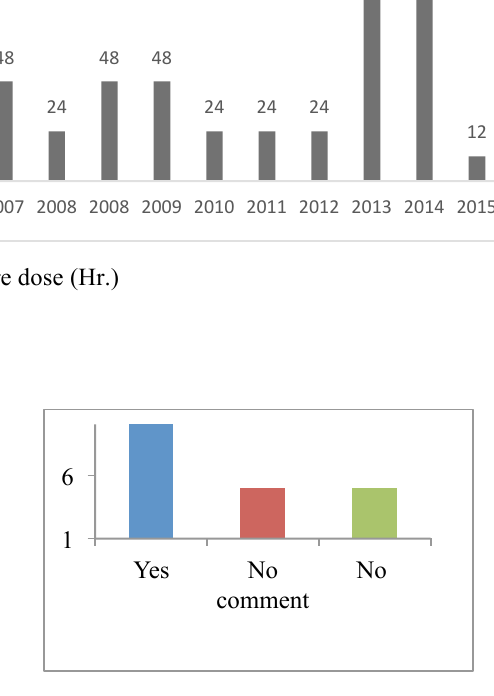
Fig.3. Association of ELF-EMF with CL Major studies were carried out near transmission line, homes, schools hence transmission lines were the main source of ELF in the frequency of 50 to 60 Hz. Distance taken during calculation of magnetic field density was varied from 0-600m and some studies have not mentioned the distance from source.